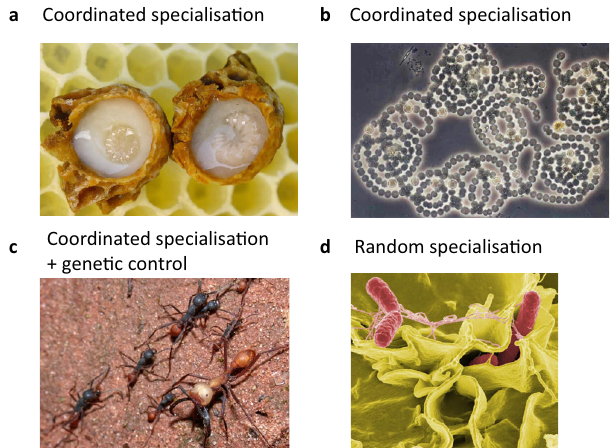
Fig. 1 Different mechanisms to produce phenotypic heterogeneity in nature. a In honey bee hives ( Apis mellifera ), larvae develop as sterile workers unless they are fed large amounts of royal jelly by adult workers (coordinated specialisation) 8 (Photo by Waugsberg via the Wikimedia Commons). b In cyanobacteria fi laments ( A. circinalis ), some individuals develop into sterile nitrogen fi xers (lighter/yellow, round cells) if the amount of nitrogen fi xed by their neighbours is insuf fi cient (coordinated